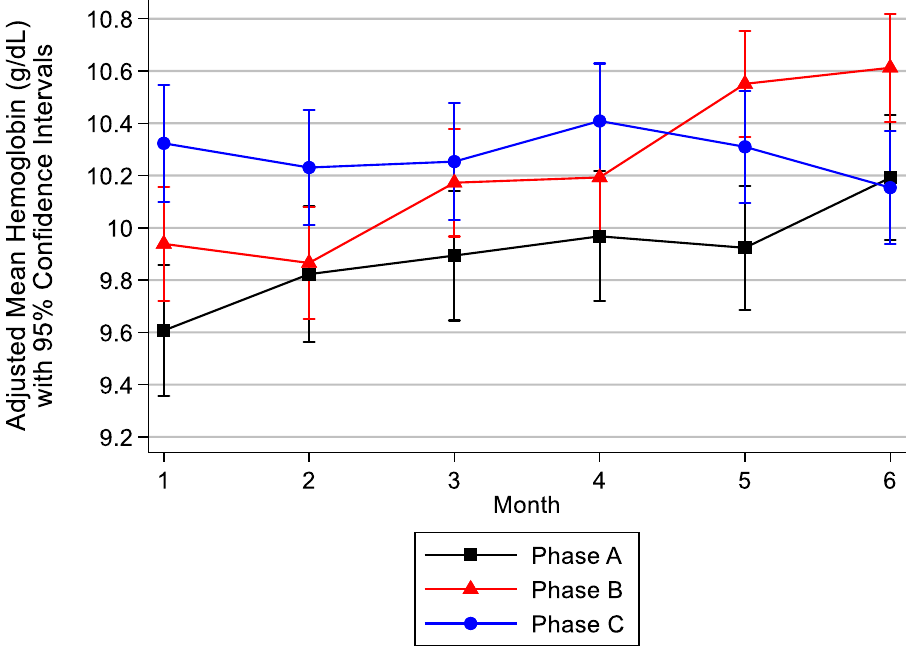
Figure 2. Adjusted Mean Marginal Hb Values by Month Stratified by Phase.